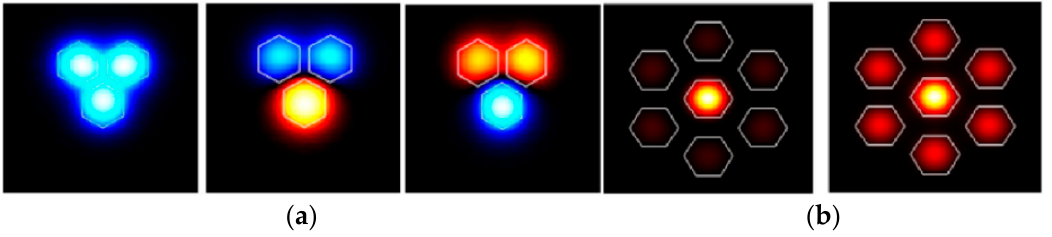
Figure 19. Simulated supermodes in the strongly coupled MCF. ( a ) The orthogonal supermodes in the three-core fiber [93], and ( b ) the center-core supermode and the symmetrical side-core supermode in the seven-core fiber [94].